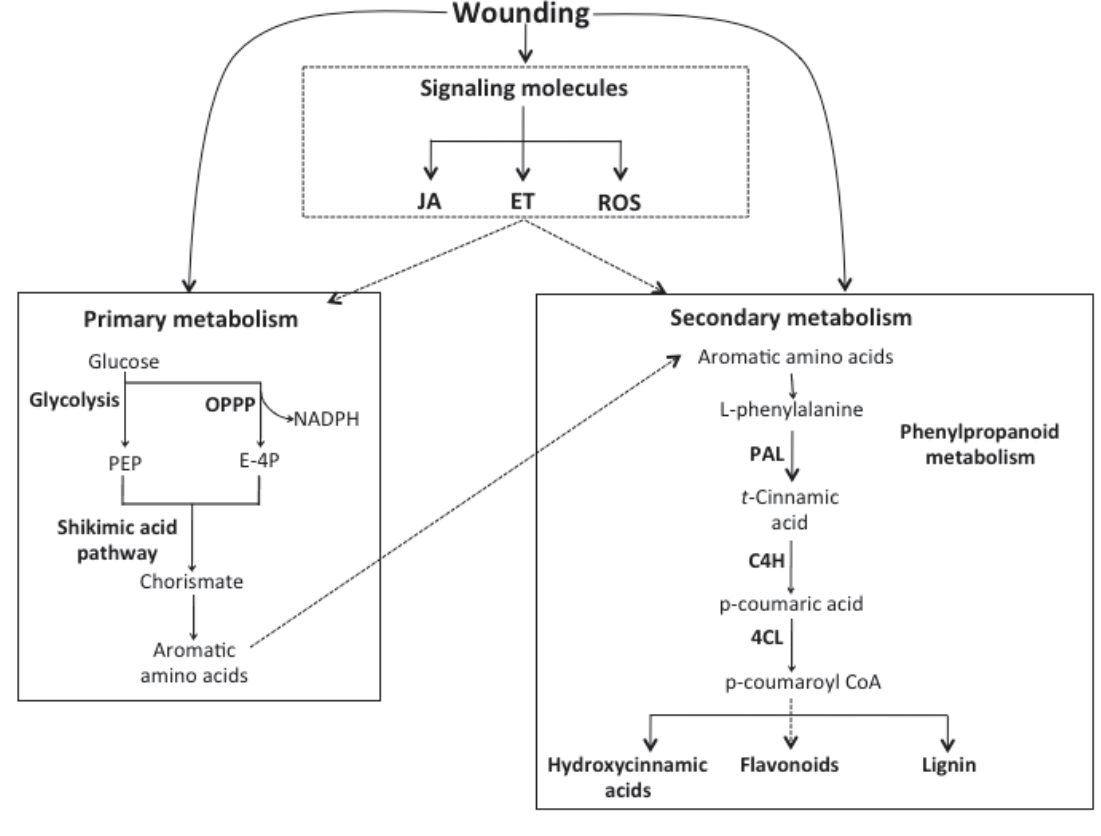
Figure 4. Wound-induced activation of pathways related with the biosynthesis of phenolic compounds in plants. Abbreviations: JA = Jasmonic acid; ET = Ethylene; ROS = Reactive oxygen species; OPPP = Oxidative pentose phosphate pathway; PEP = Phosphoenolpyruvate; E-4P = Erythrose-4 phosphate; PAL =